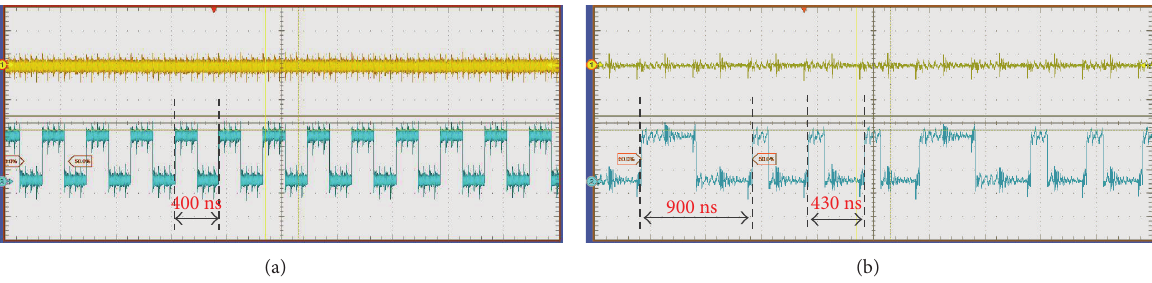
Figure 15: Measurement results of clock divider operation. (a) Operation under normal conditions. (b) Operation under failure